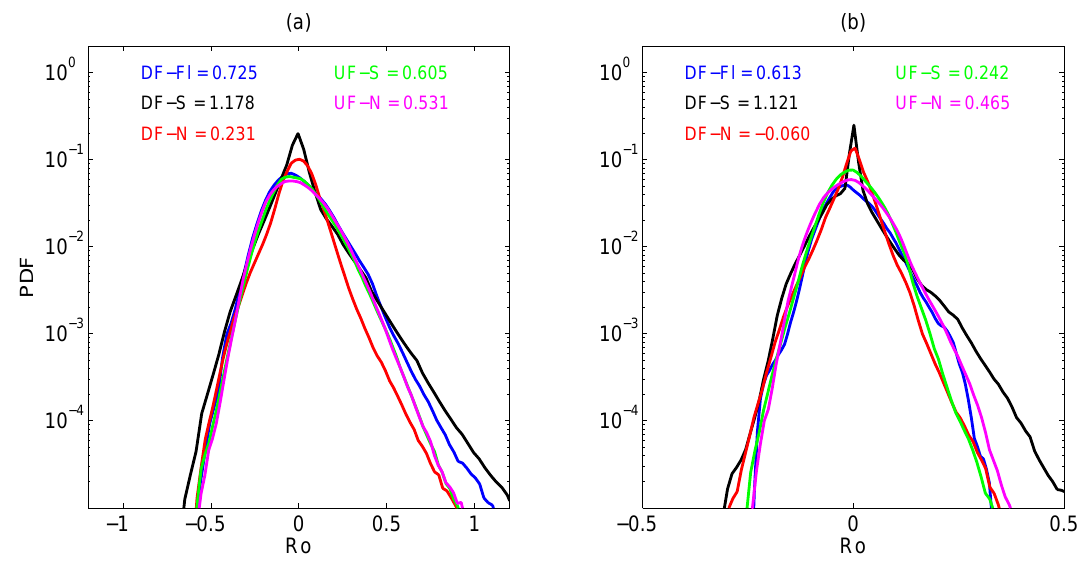
Figure 6. Probability density function (PDF) for ( a ) surface Rossby number, and ( b ) Rossby number at 180 m depth averaged from day 800 to 1000 for Experiments (1)–(5). Values of PDF skewness are labeled using the same color for each